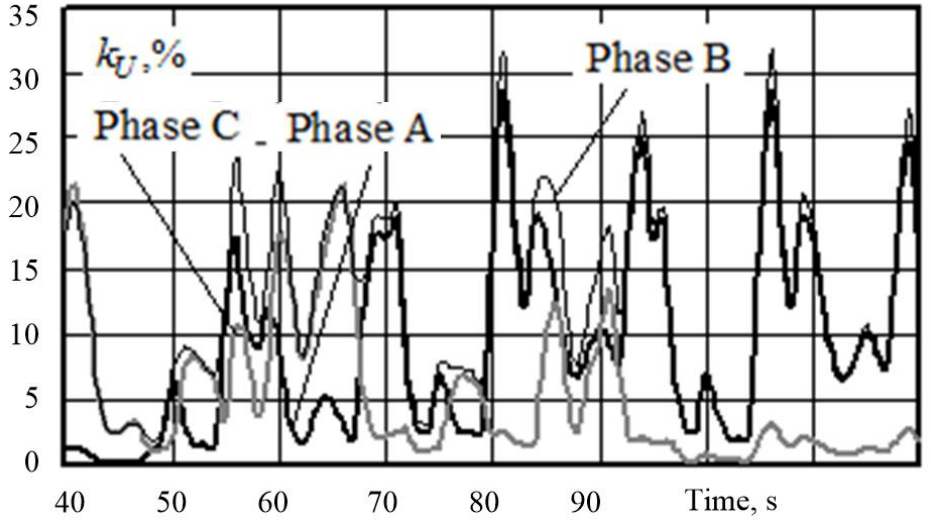
Figure 17. Total harmonic distortion at 6 kV buses of TS2.